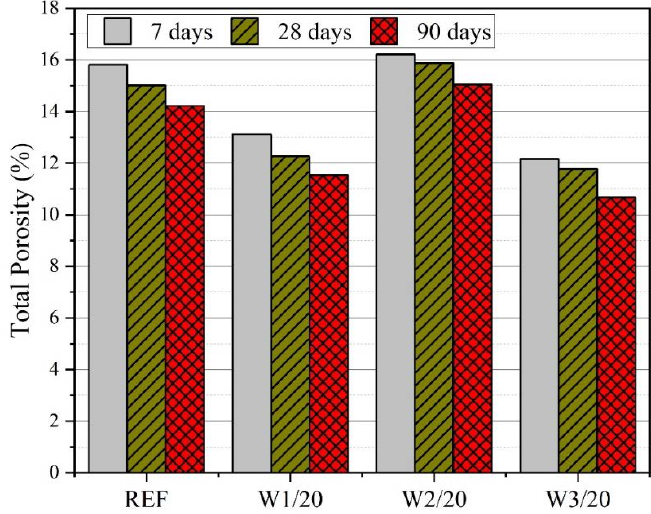
Figure 7. Total porosity of mortar specimens.